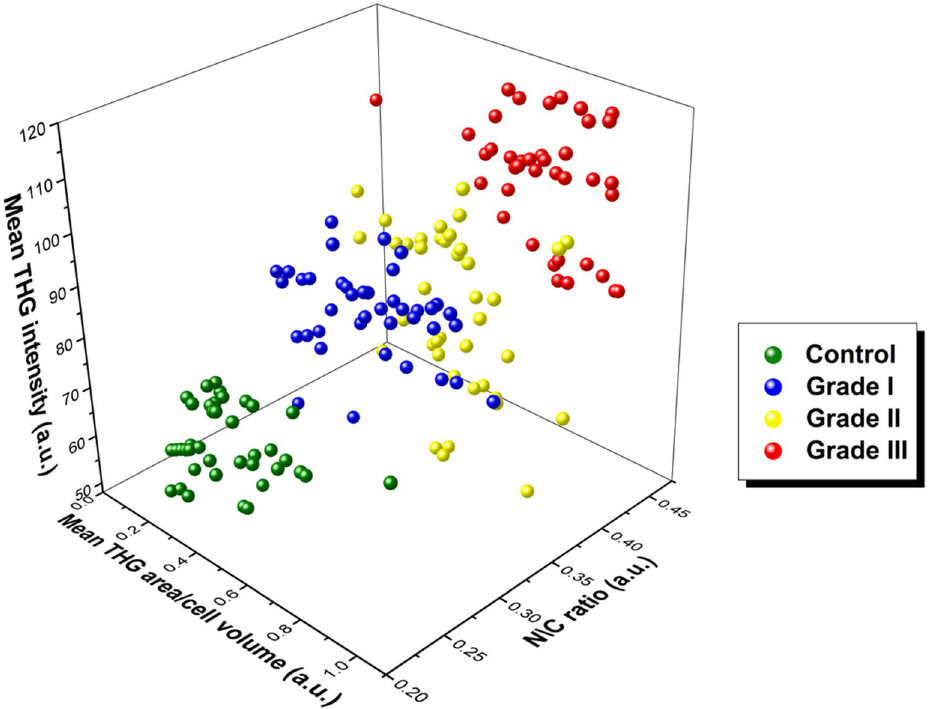
Figure 5. 3D graph for the distinction between cancerous and control (grade 0) tissues via THG signals quantification. Mean THG area/cell volume area in x-axis, N/C ratio in y- axis and THG intensity values in z-axis. The grade III and the control tissues clearly appeared as separable sub populations of spots in the scatter plot (N = 40 for each tissue